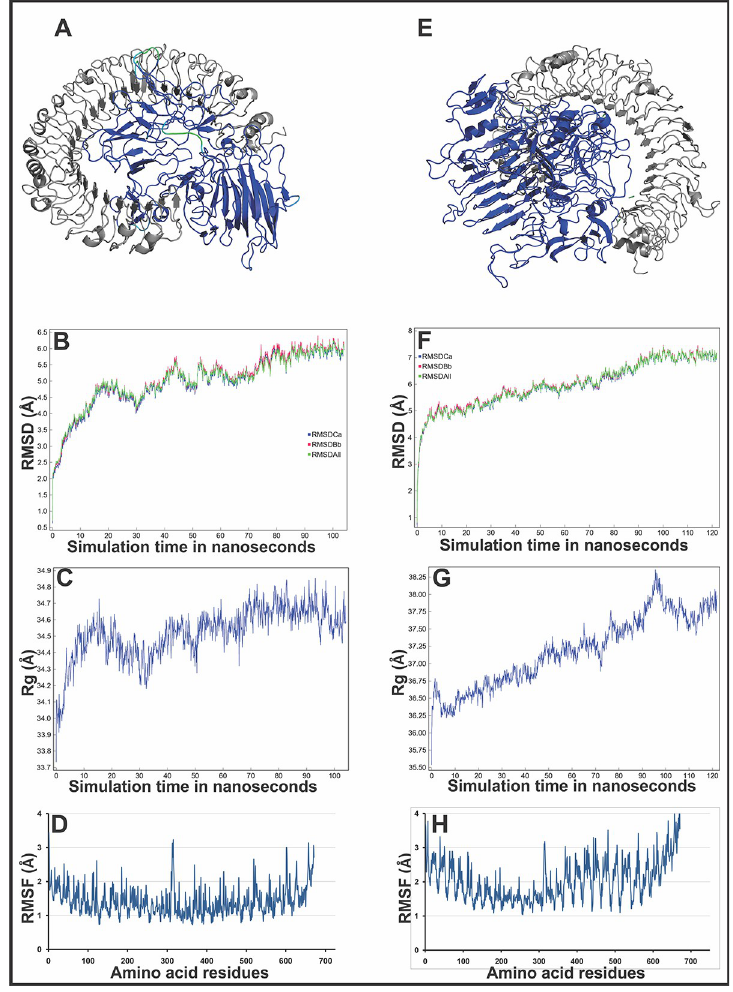
Fig 7. Molecular docking and dynamics simulation study of CTL and HTL MEVs with TLR3. (A) CTL and (E) HTL MEVs (VIBGYOR) docked complex with TLR3 (gray). Both the complexes are forming several hydrogen bonds in the MEV and TLR3 interface, as shown by green dots. B-Factor of the docked MEVs is shown by a rainbow (VIBGYOR) presentation. The regions in blue being indicated stable and the region in red indicate unstable. In the above complexes, most of the region of docked MEVs is in blue and with the very small region is green, yellow or orange, hence the complexes are predicted to be very stable. (B) and (F), RMSD as generated by the molecular Dynamics simulation study of CTL, HTL MEVs and TLR3 complexes. (C) & (G) Rg (radius of gyration) across the time window of 100 nanosecond. (D) & (H) , RMS fluctuation for all the atoms of the CTL, HTL MEVs and TLR3